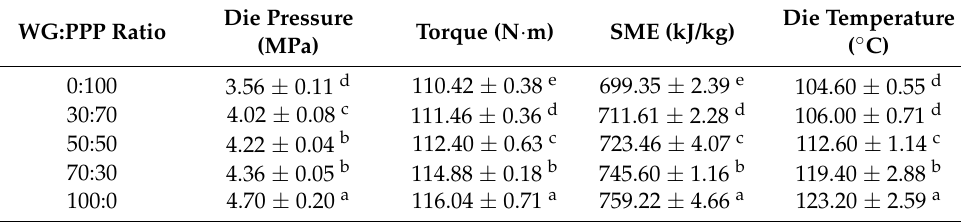
Table 4. System response parameters for extrusion processes of raw materials with different mixing